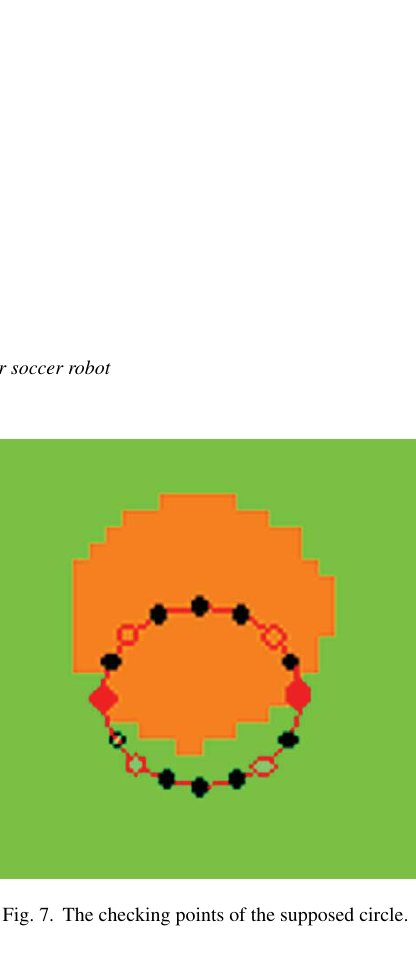
edge pixels in the ball area is assumed to be a diameter (Fig. 7) and a supposed circle is drawn. After checking all the supposed circles, the diameter and ball centre are